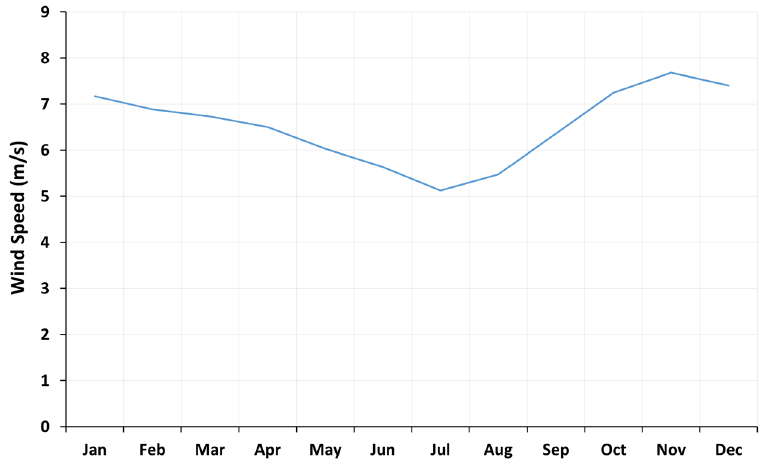
Figure 9. The site’s monthly averaged wind speed data [41].